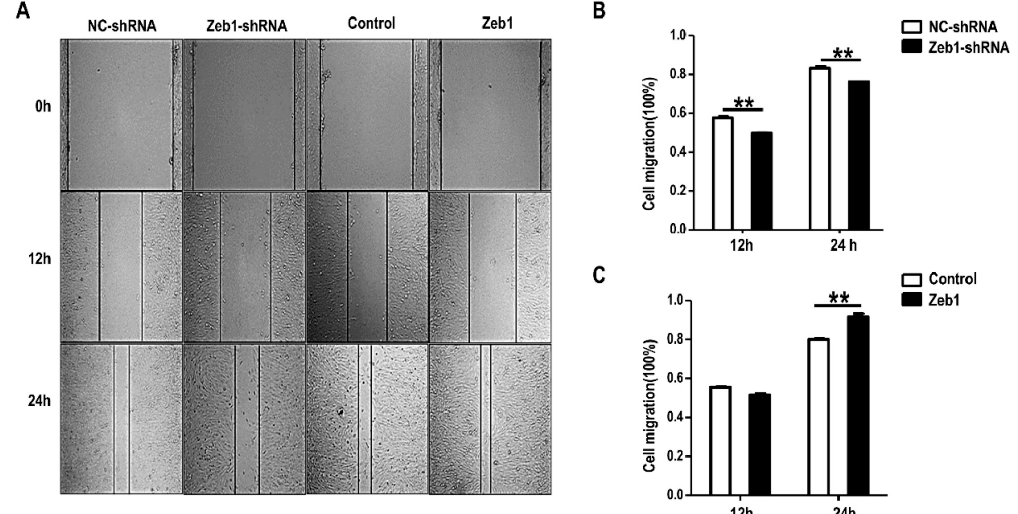
Figure 4. Knock-down of Zeb1 inhibits mK3 cell migration while overexpression of Zeb1 promotes cell migration only after 24 h. ( A ) Cell migration of mK3 cells was measured via wound healing assay. The width of wound area was calculated at three time points (0, 12, 24 h) starting from the point when mK3 cells were transfected 48 h later. The transfection way was same with Figure 2. Zeb1 knock down led to lower apoptosis rate but Zeb1 overexpression resulted in higher rate, compared with the controls; ( B , C ) The quantification of wound healing percentage (100%) was exhibited with the error bars representing mean ± SD ( n = 3). ** p < 0.01, negative control vector.